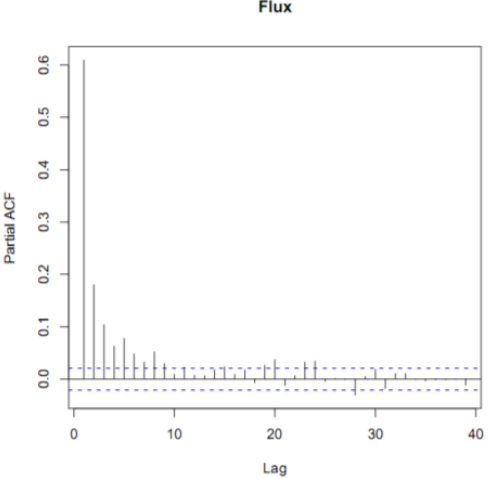
Figure 2. The partial autocorrelation function (ACF) diagram of hourly GEM fluxes for the entire campaign. The dotted lines indicate the 95% confidence interval above or below hours significantly correlated with hour zero. The time lag on the x-axis is in units of hours and the Partial ACF on the y-axis in units of percent